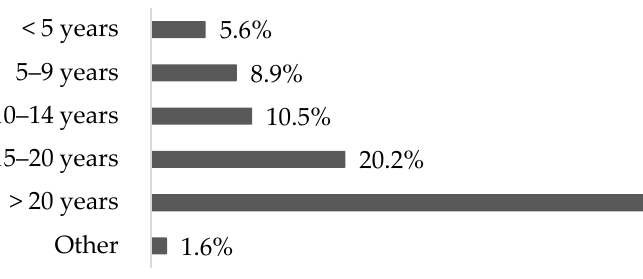
Figure 1. Job titles of survey participants.